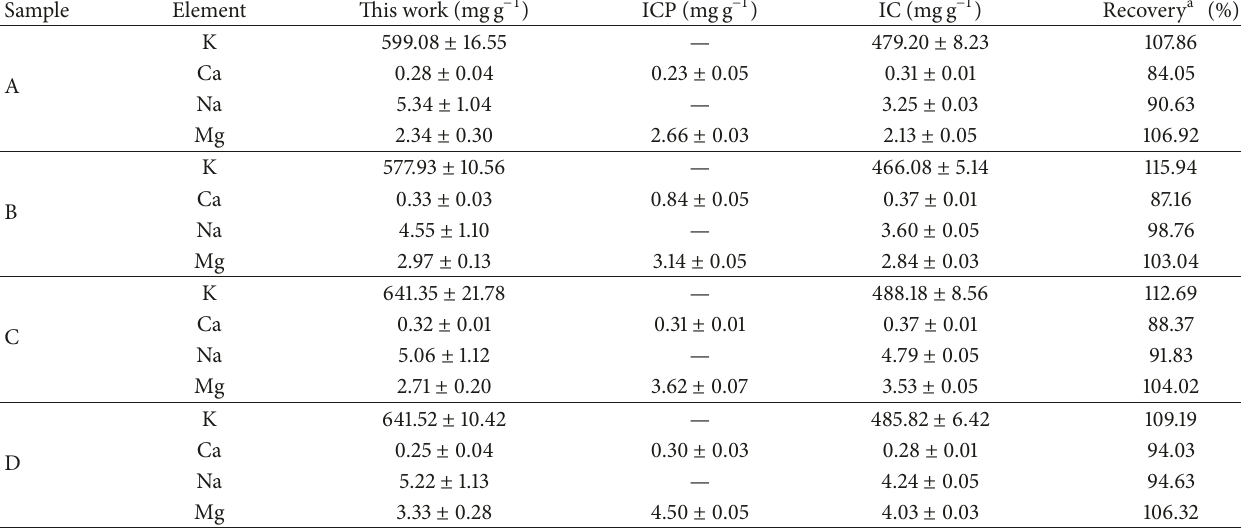
Table 3: Measurement results of K, Ca, Na, and Mg in real salt mines by LCGD-AES, ICP, and IC.